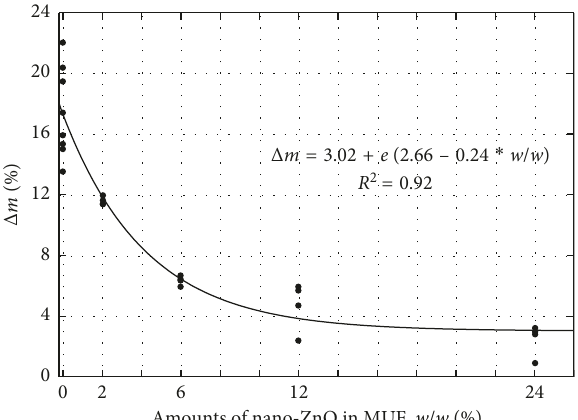
Figure 1: Exponential correlation between a higher content of nano-ZnO in MUF glue ( w / w , %) used in the production of PBs and a smaller weight loss ( m , %) of the nano-ZnO-treated PBs exposed to the attack by the brown-rot fungus Coniophora Δ nitrate and 1,2,4-triazole derivative in amount of 3.0 kg per m 3 of PB in amino glues). Bayatkashkoli et al. [53] showed